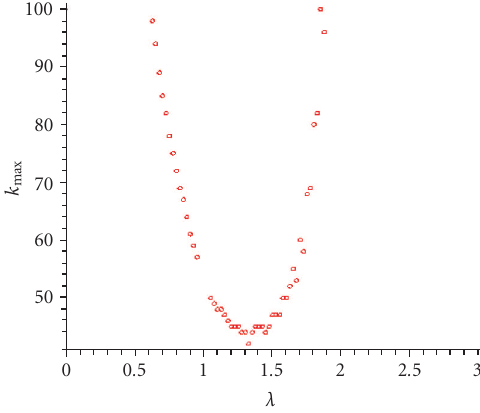
Figure 5.4. Modified Newton algorithm with di ff erent values of λ for x = 2 . 88418640 × 10 8